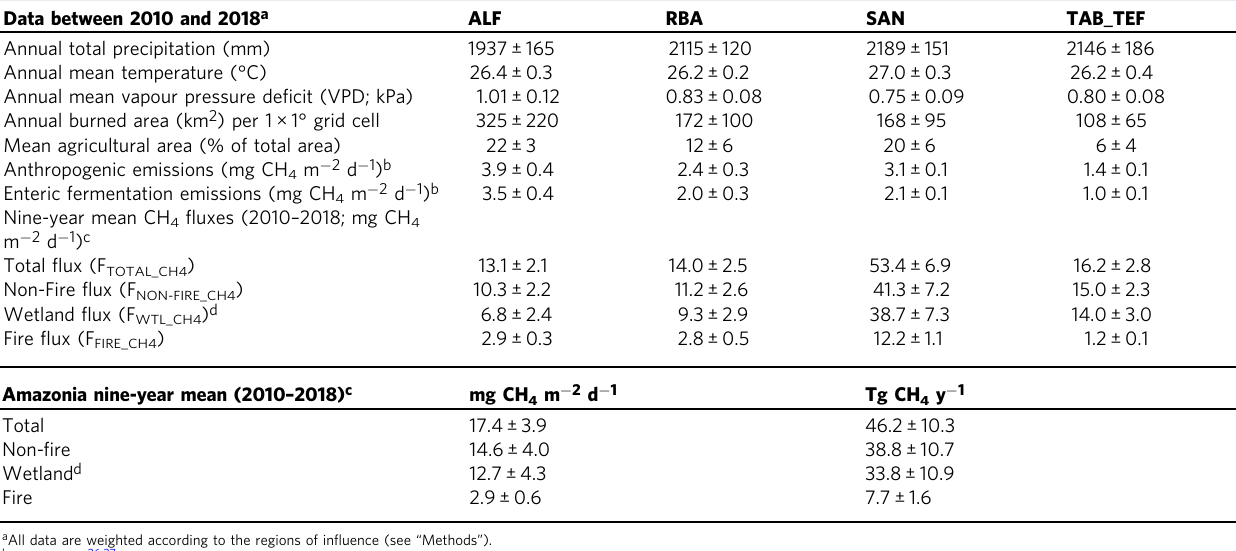
Table 1 Climate and human disturbances characteristics of the regions of in fl uence for ALF, SAN, RBA and TAB_TEF, and 9-year mean CH 4 fl uxes for each region and for the whole Amazonia